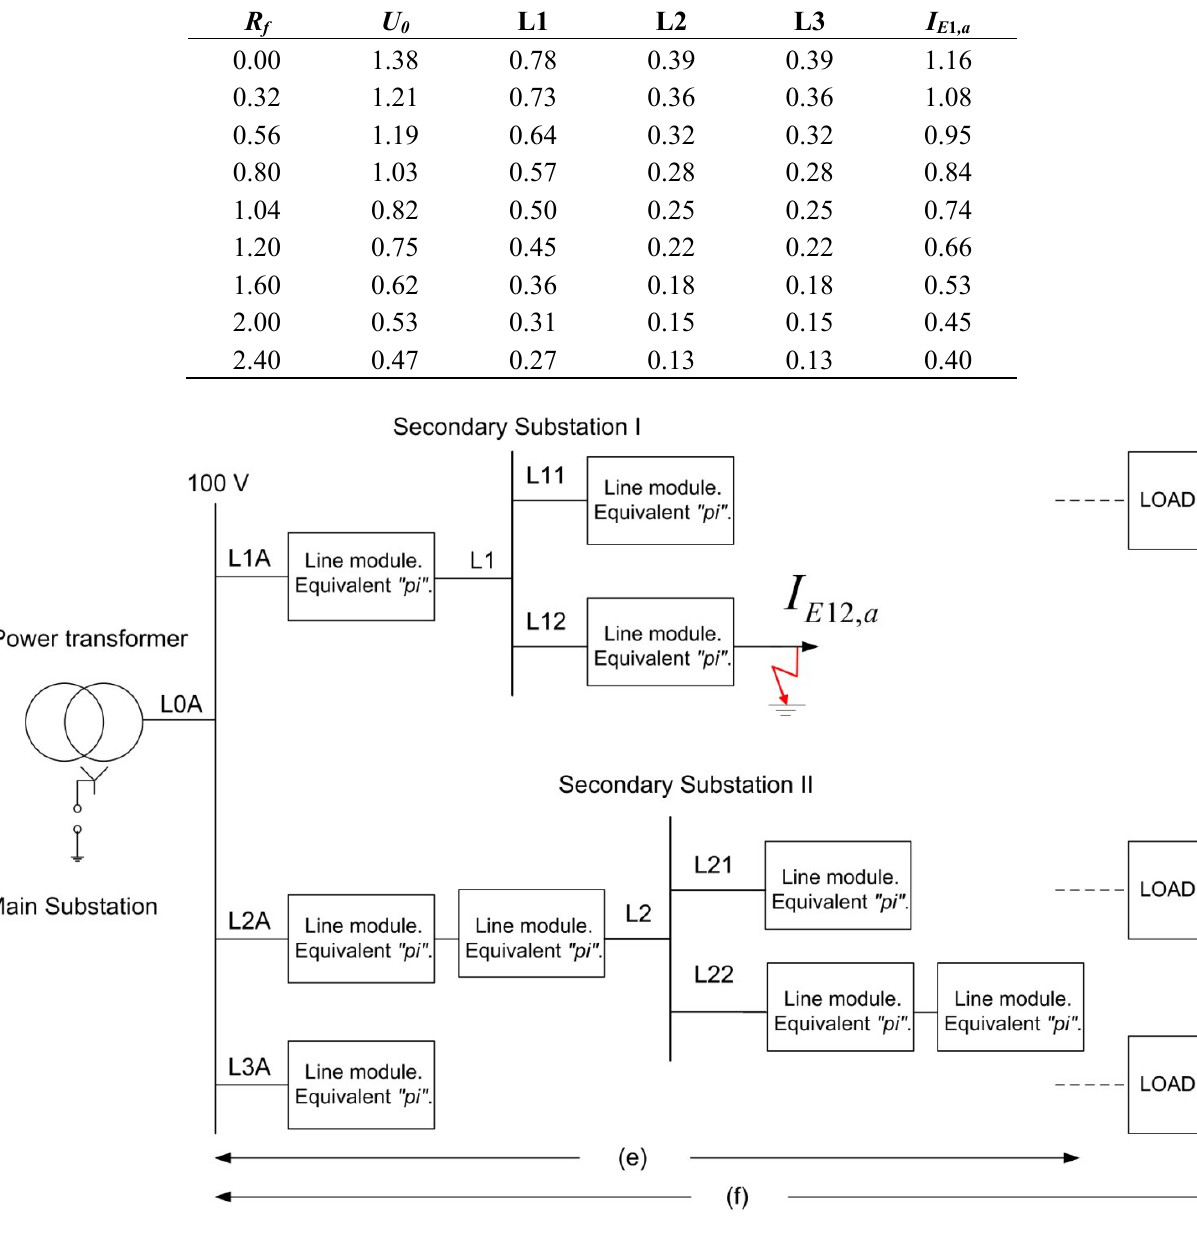
Figure 18. Multiple line network. SPGF at Line